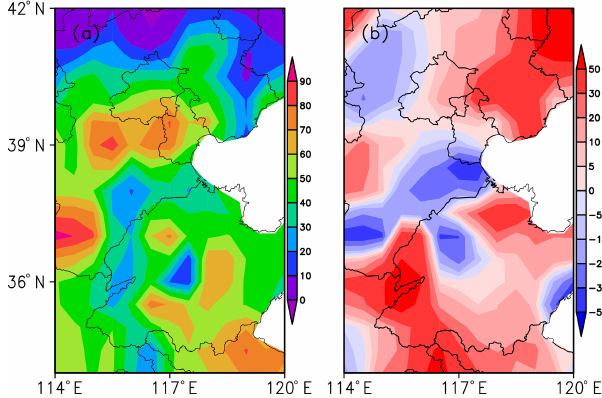
Figure 3. Distributions of WHD from 1979 to 2012 (a) and anoma- lies in 2014 relative to 1979–2012 (b) .